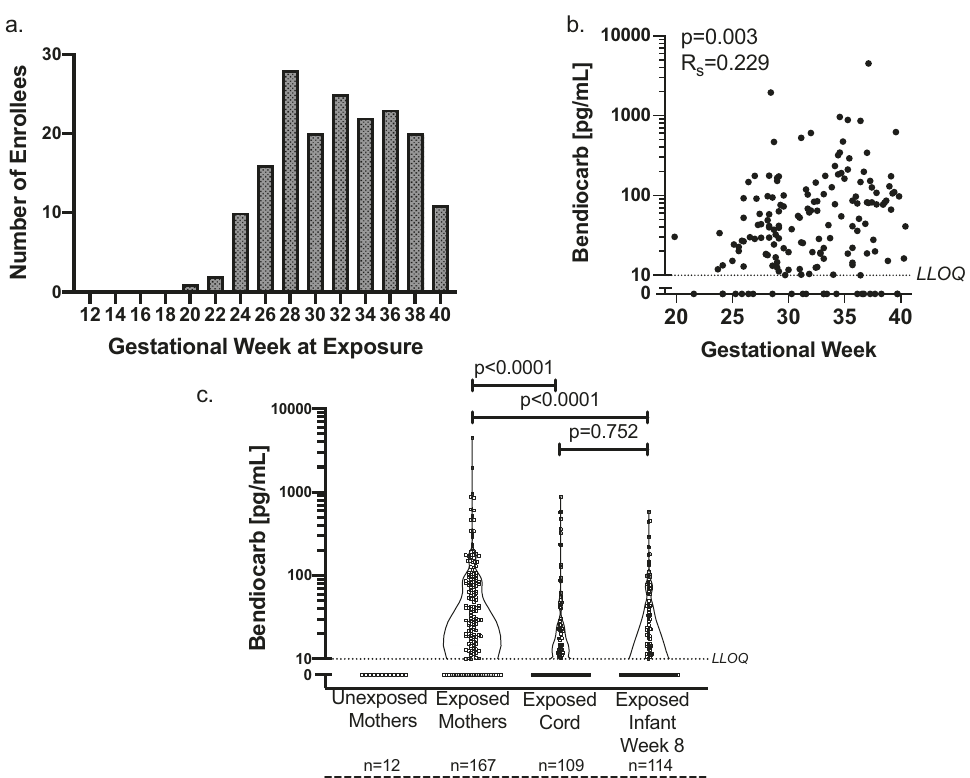
Fig. 1 Bendiocarb is detectable at high levels in maternal plasma, is trans-placentally transferred to the fetus, and is present in infants at 8 weeks of life. a Timing of household bendiocarb spraying by gestational week. b Maternal plasma bendiocarb concentration at the time of delivery, by gestational week of exposure ( n = 167, Spearman ’ s correlation). The dotted line indicates an LLOQ of 10 pg/mL. c Bendiocarb concentration was evaluated in available plasma from unexposed and exposed maternal plasma at delivery, exposed cord plasma, exposed infant plasma at 8 weeks of life (prior to repeat household pesticide exposure, LLOQ 10 pg/mL, Wilcoxon signed-rank test, single replicate). Bendiocarb was detected above the lower limit of quanti fi cation in 0/12 (0%) of unexposed maternal plasma at delivery, 143/167 (86%) of exposed maternal plasma at delivery, 51/109 (47%) of exposed cord plasma, and 66/114 (58%) of exposed infant plasma at 8 weeks of life. Two-sided p values were calculated for all test